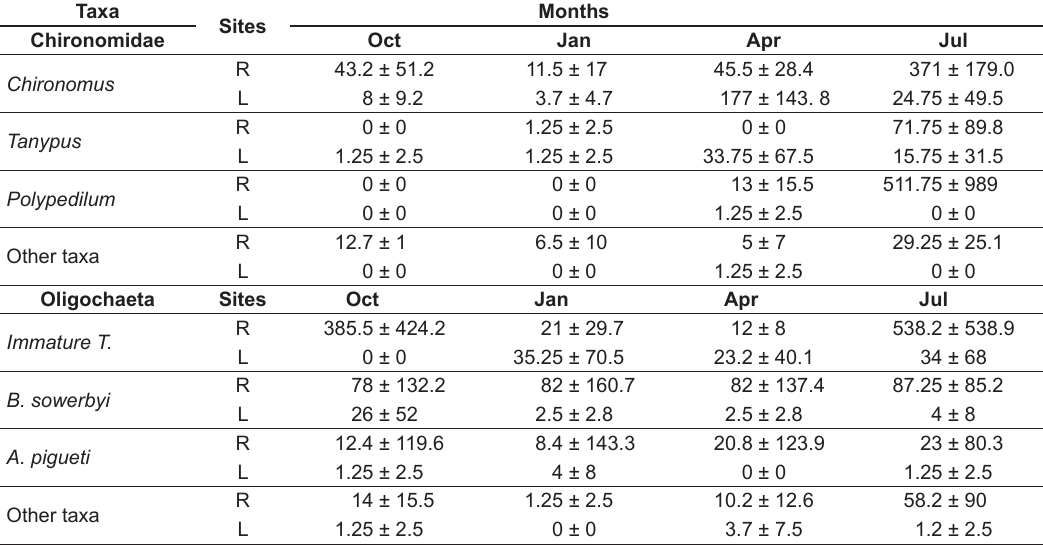
Table 2. Means and standard-deviations of the densities (ind.m -2 ) of some Chironomidae and Oligochaeta taxa in October 2013 and January, April, and July 2014 at sites in the Guareí River (R) and the lateral area (L).